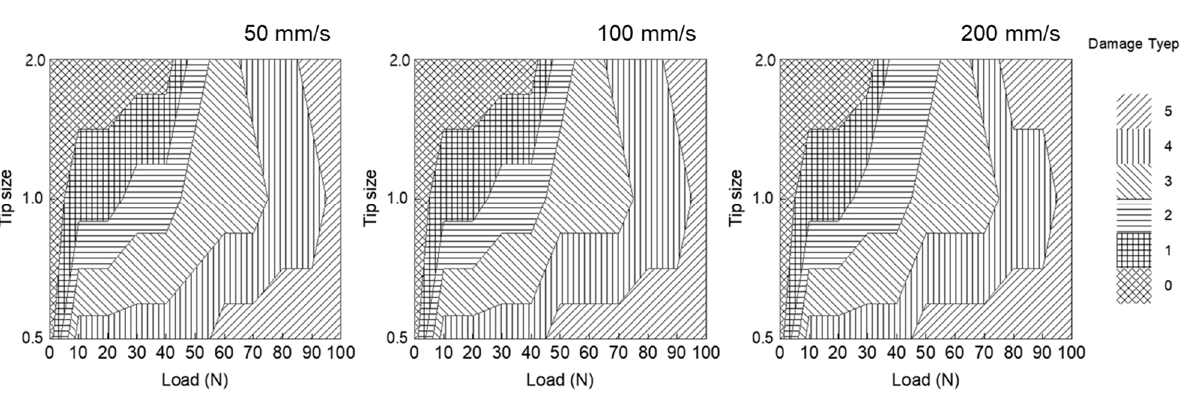
Figure 2. Damage mechanism map based on Mode A scratch tests for various scratch speeds and tip size.